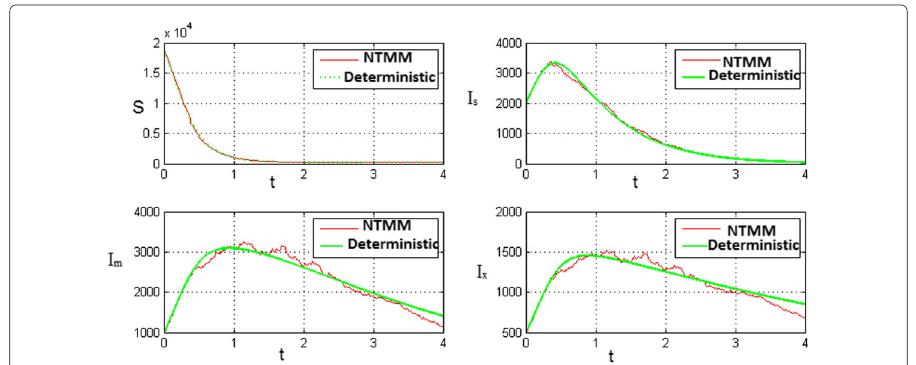
Fig. 6 Trajectories of the mean solutions of stochastic and deterministic systems with when θ = 1, ξ = 0.09 , h = 0.0133 by using NTMM